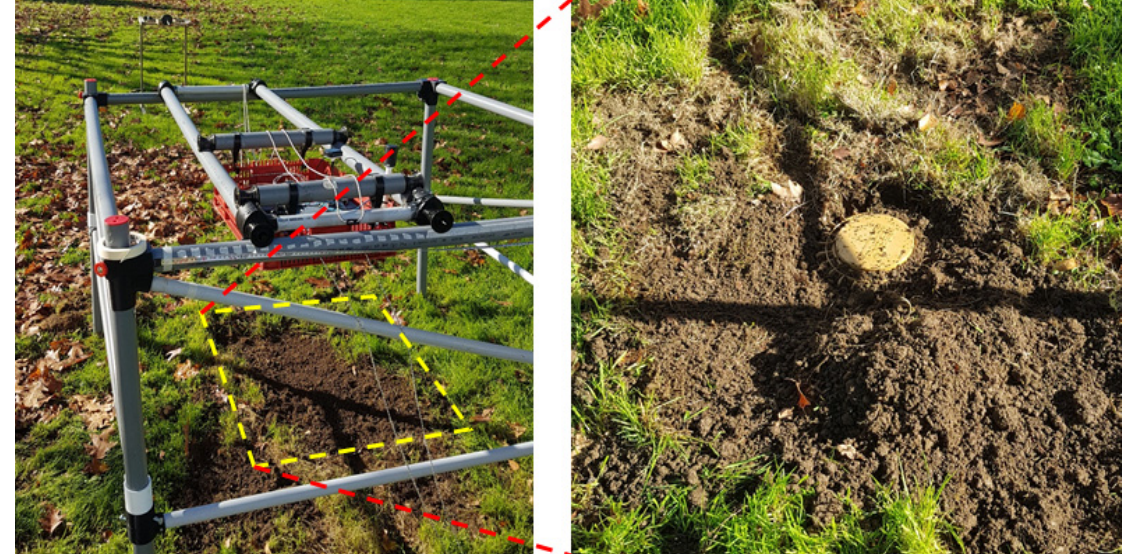
Figure 10. Picture of the measurement setup with an anti-tank plastic landmine buried on the ground. A picture of the anti-tank landmine before burying it can be observed in the right picture. XY cut, plane z = -5 cm YZ cut, plane x = 491 cm